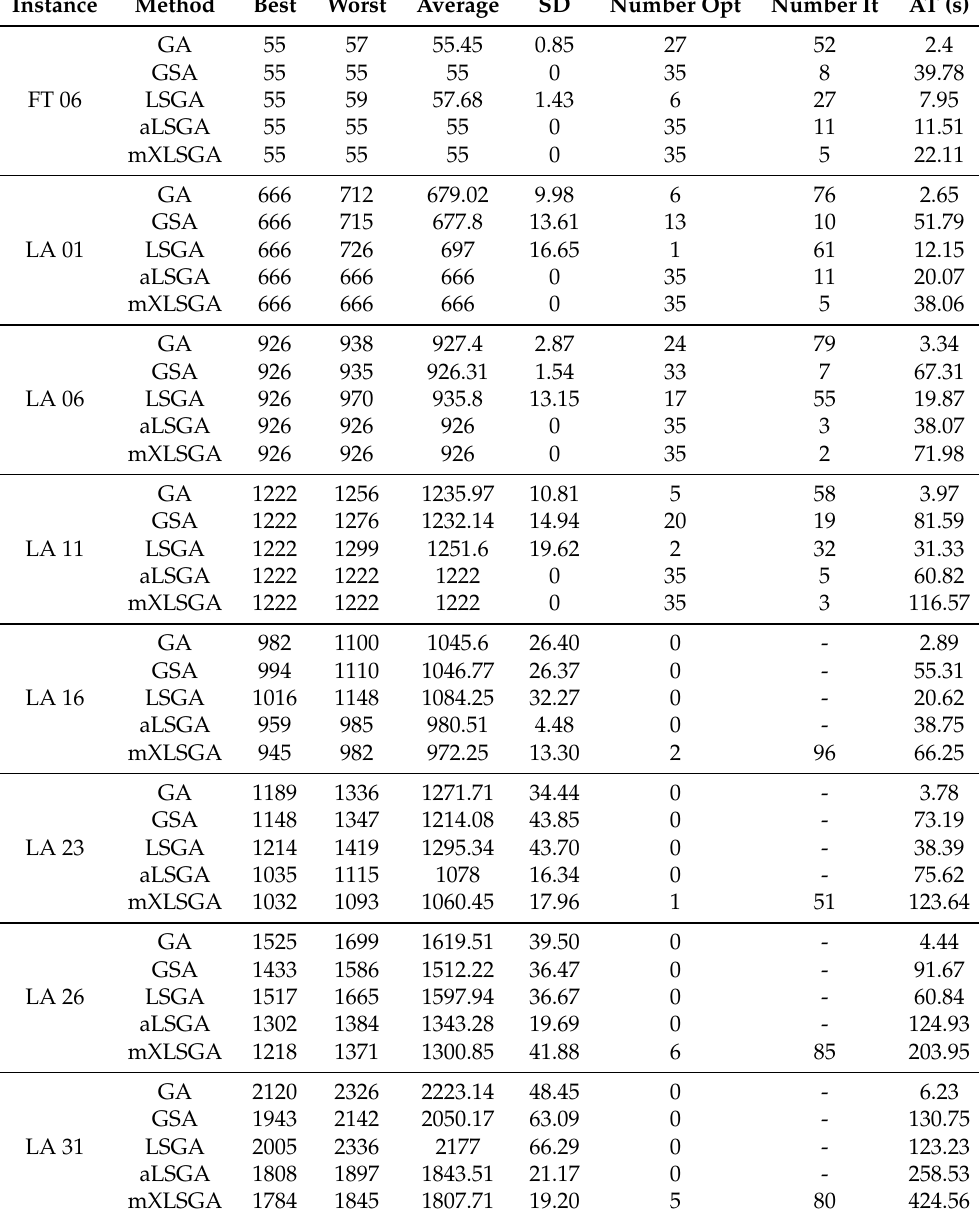
Table 7. Genetic Algorithm (GA)-like methods statistics. The symbol “-” means that the method was not able to reach the optimum